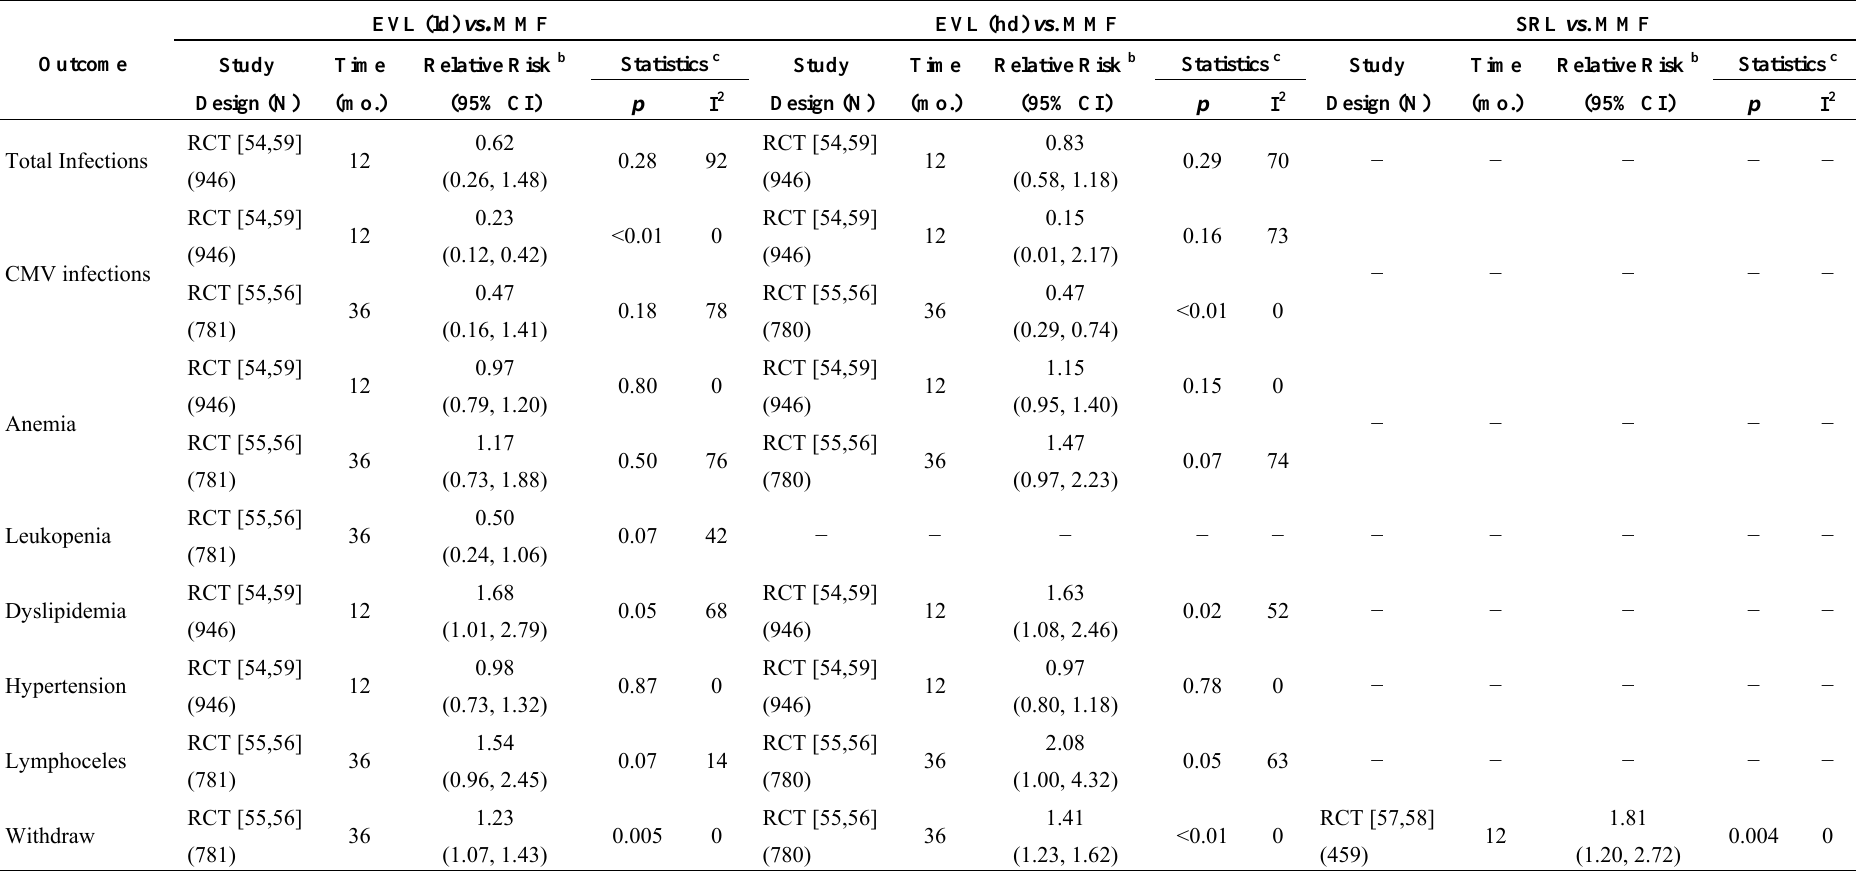
Table 6. Meta-analysis results of outcomes reported by studies comparing EVL or SRL vs. MMF a